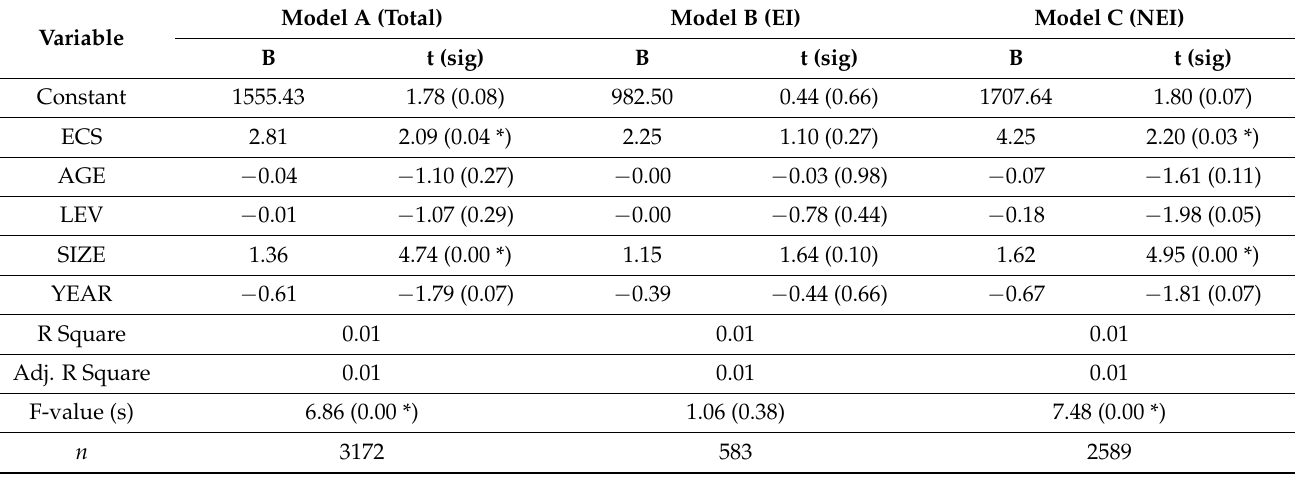
Table 8. Robustness test